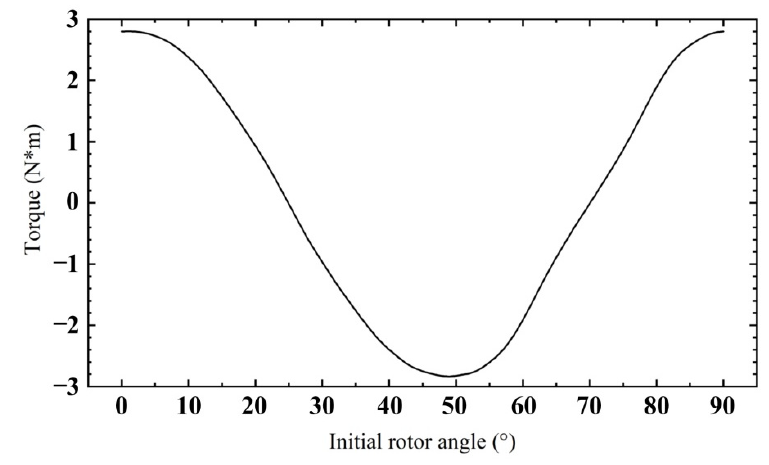
Figure 21. Relationship between rotor torque and initial rotor angle.